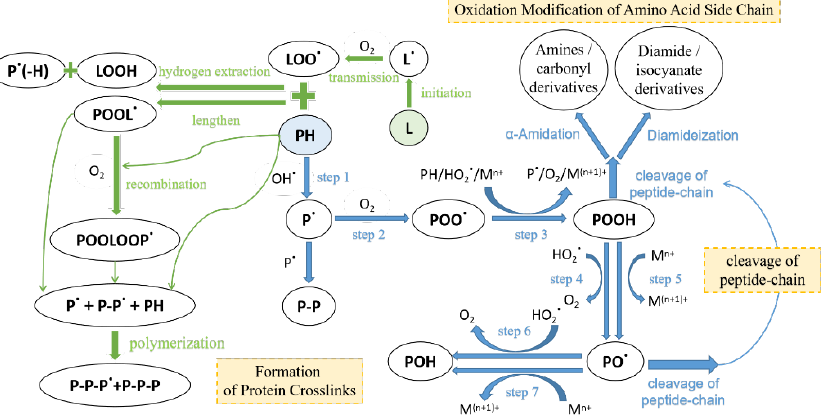
Figure 1. Mechanism of Protein Oxidation in Fermented Meats [7,25]. Notes: P = protein; L = lipid. The blue color represents the metal ion-catalyzed protein oxidation mechanism, and the green color represents the lipid peroxidation-induced protein oxidation.